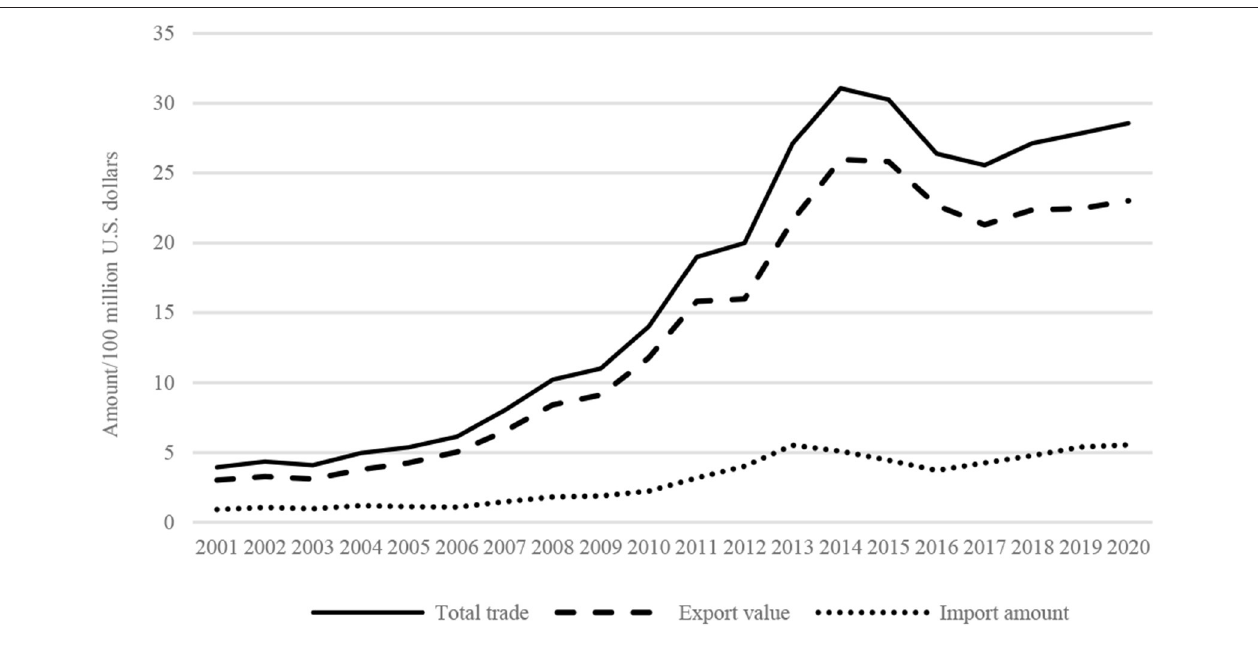
FIGURE 4 | Evolution of China’s imports and exports of TCM products in